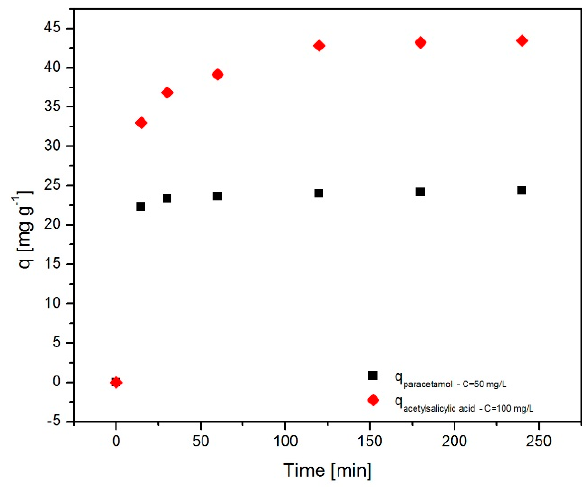
Figure 8. Adsorbed amount versus time for paracetamol and acetylsalicylic acid on the Fe 3 O 4 @C matrix.